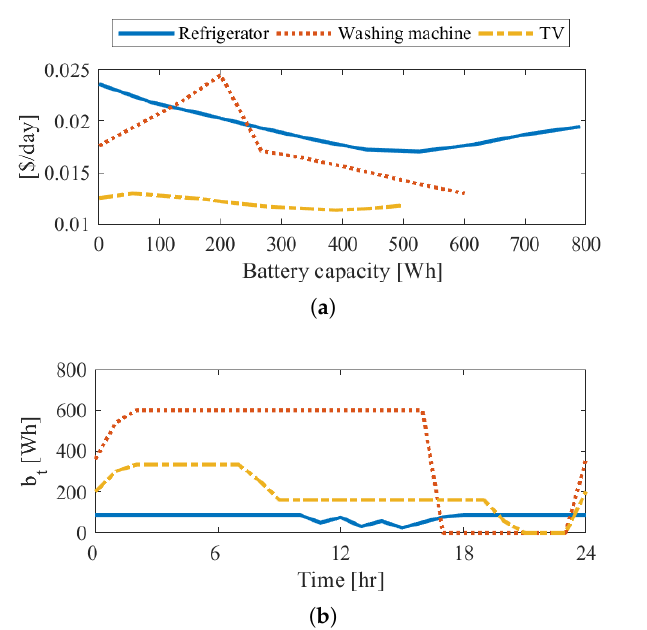
Figure 6. Optimal battery capacity analysis results of Case 3, δ 1 = 0.9, δ 2 = 0.9. ( a ) Home appliance daily electricity cost. ( b ) Home appliance battery SoC, K ref = 90 Wh, K wash = 600 Wh, K TV = 330